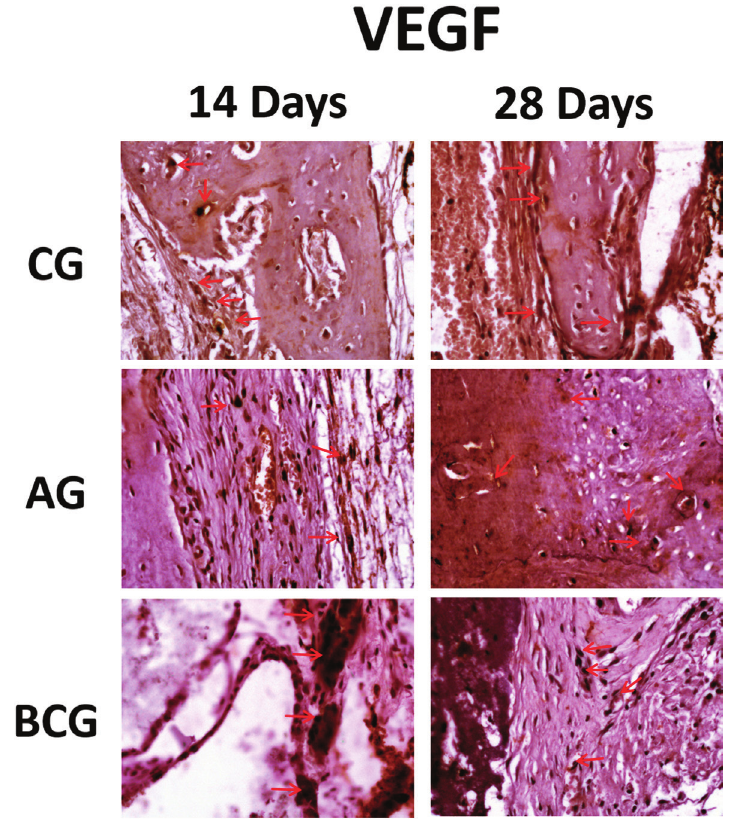
Figure 8- VEGF immunostaining at 14 days for the experimental groups (CG: moderate; AG: light; BCG: moderate) and at 28 days (CG: moderate; AG: moderate; BCG: moderate). Immunolabeling indicated by red